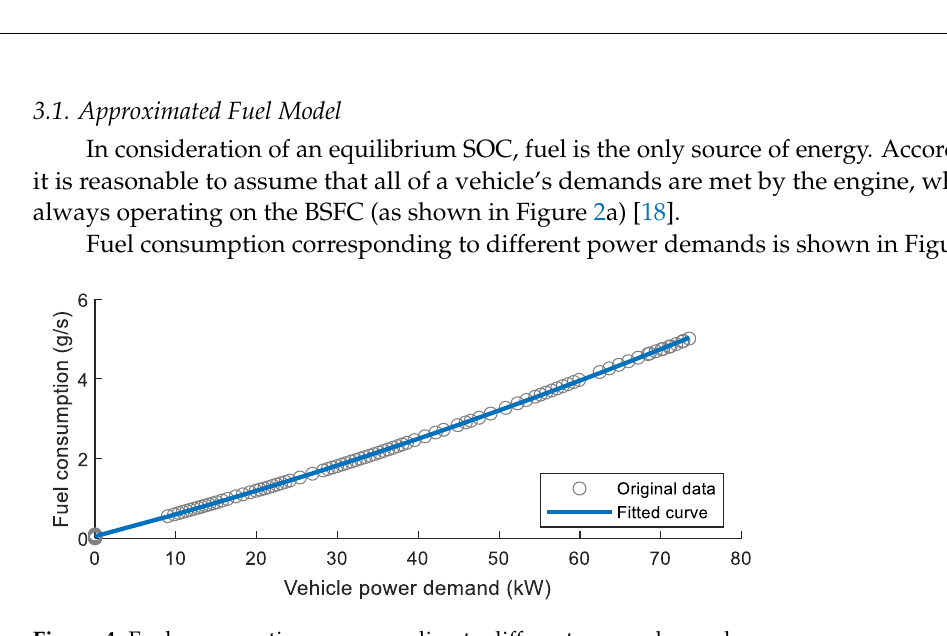
Figure 4. Fuel consumption corresponding to different power demands.